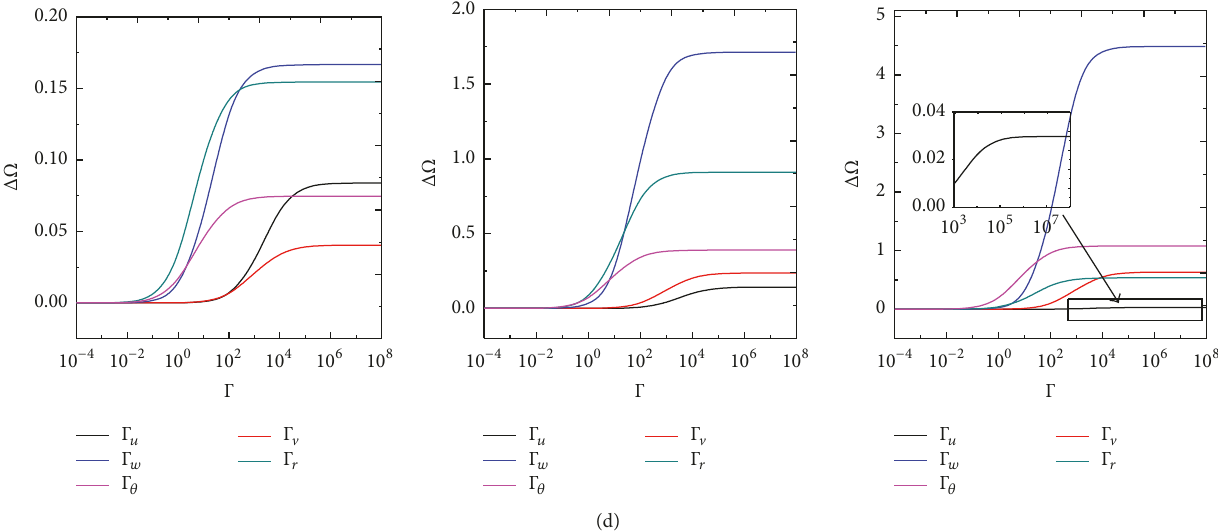
Figure 5: Variation of the frequency parameters ΔΩ versus the elastic restraint parameters D for FG sandwich sector plate ( 𝑅 0 /𝑅 1 = 0.5, 𝜙 = 120 ∘ , ℎ/𝑅 1 = 0.2, and 𝑝 1 = 𝑝 3 = 5 , 2-2-1): (a) Type 1-1; (b) Type 1-2; (c) Type 2-1; (d) Type 2-2.